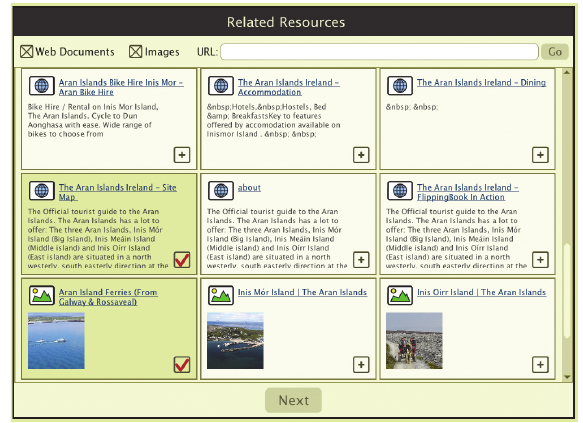
Figure 2: Selection of related resources suggested by the system.